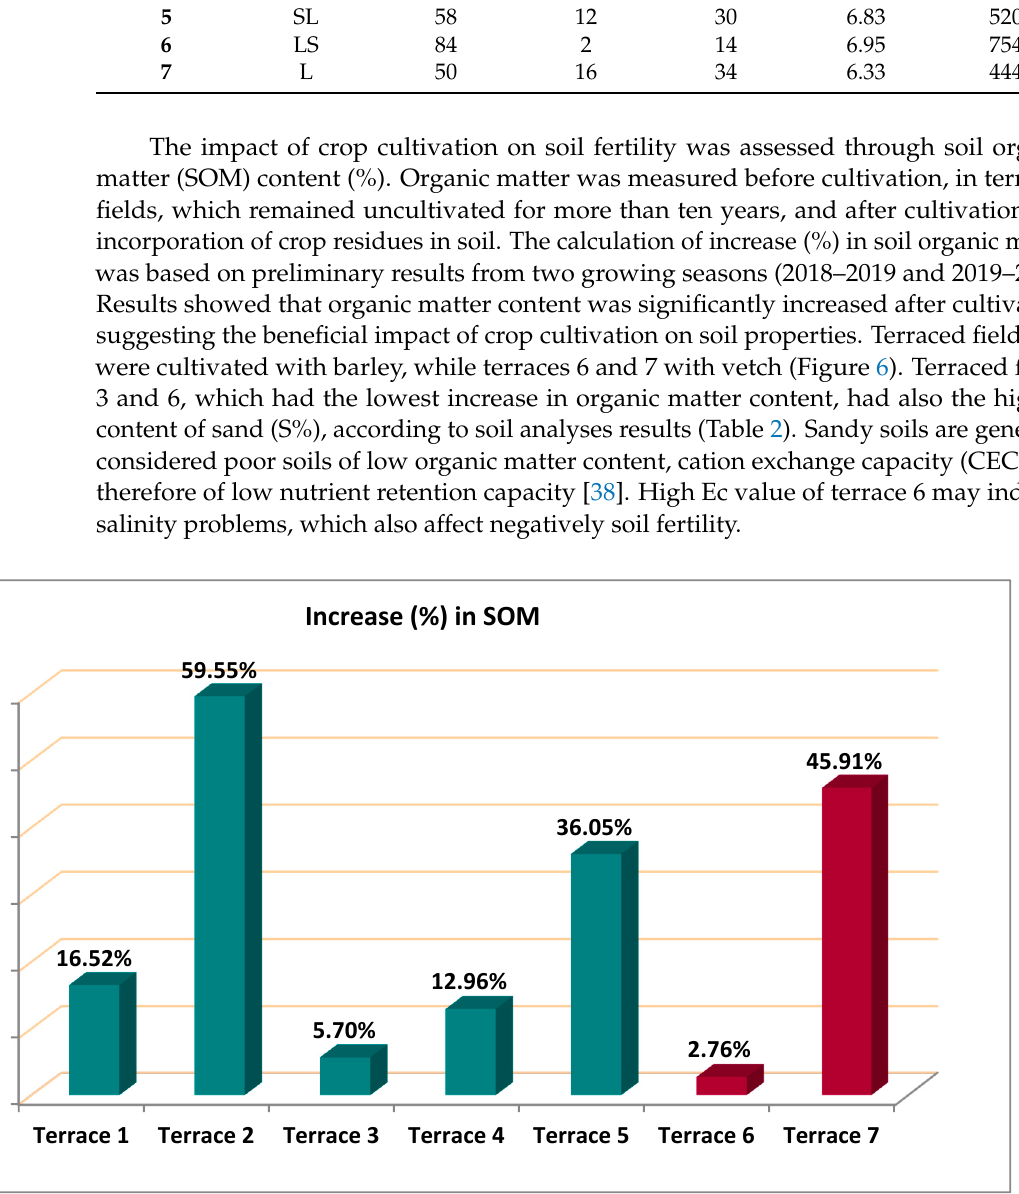
Figure 6. Increase in soil organic matter (SOM) content (%) in selected terraced fields after crop cultivation. Terraces 1–5 were cultivated with barley ( Hordeum vulgare ), while 6 and 7 with vetch ( Lathyrus sp.).